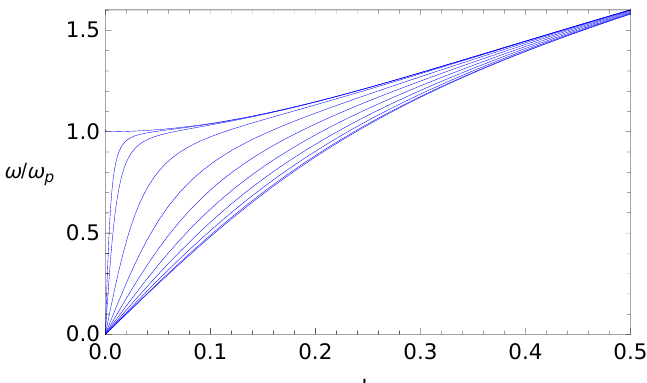
Figure 11. E(cid:11)ect of the double-trace deformation for a layered system on a response function with low-energy sound modes. For p‘ = 0 we obtain a gapped plasmon mode, while for any value of p‘ 2 (0 ; (cid:25) ] the low-energy dispersion relation is linear, with p‘ = (cid:25) having the lowest speed. The plot shows the plasmon dispersion for p‘ = f 0 ; (cid:25)= 50 ; (cid:25)= 25 ; n(cid:25)= 8 g , with n 2 [1 ; 8] an